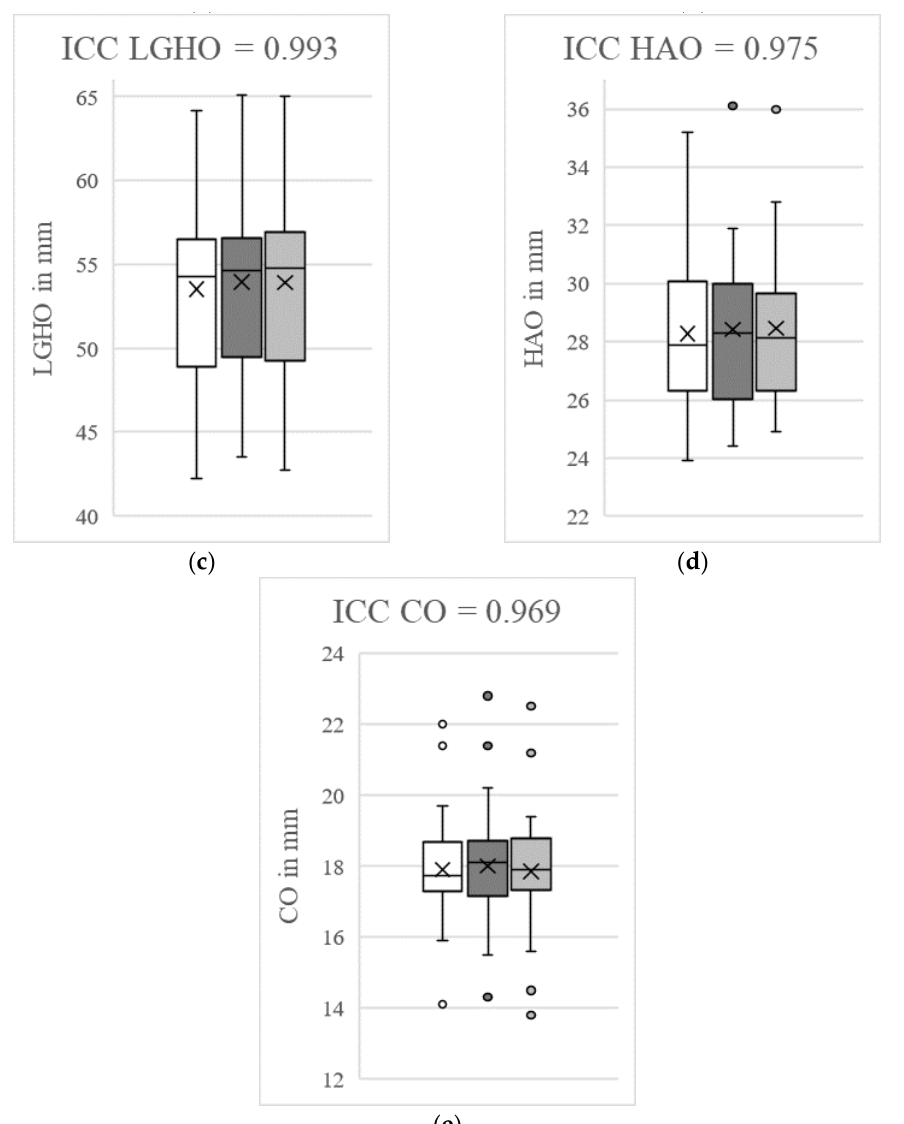
Figure 3. Determination of intraclass/interclass correlation coefficients (ICCs) for humeral offset (HO, a ), glenoidal offset (GO, b ), lateral glenoidal humeral offset (LGHO, c ), humeral shaft axis offset (HAO, d ) and cortical offset (CO, e ). The white box plots represent the initial measurements by LEB and the dark grey box plots represent the second recordings by LEB. The box plots marked in light grey reflect the measurements by MPM. The figures show the cumulative ICCs between the initial and control measurements by LEB and the observations by MPM. The outliers are marked with points. Excellent measurement reliability (ICC > 0.9) was determined for all the offset